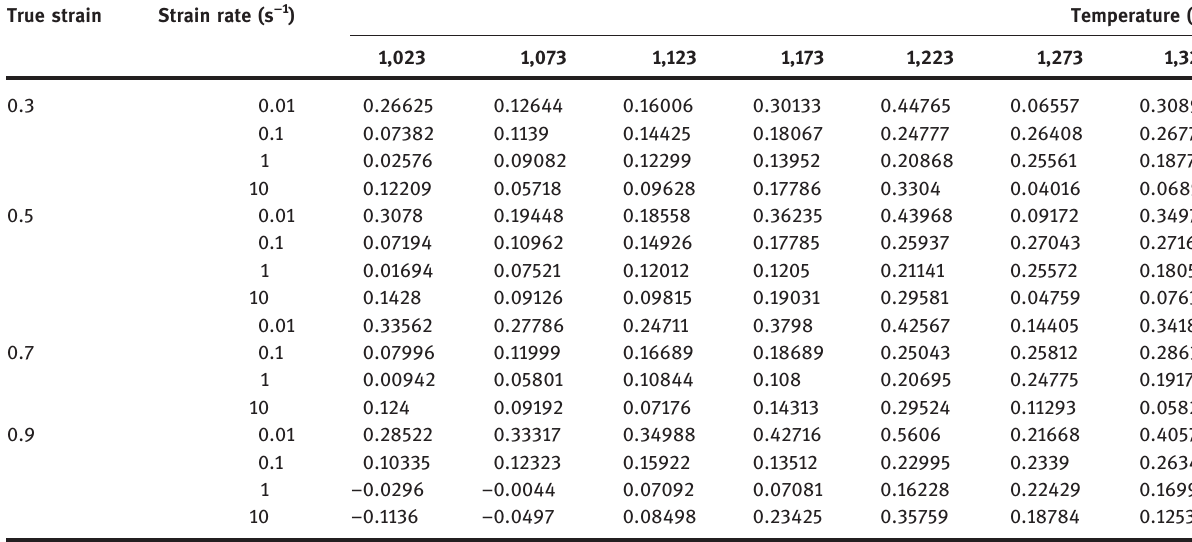
Table 1: The m -values calculated at different forming temperatures, strains and strain rates. True